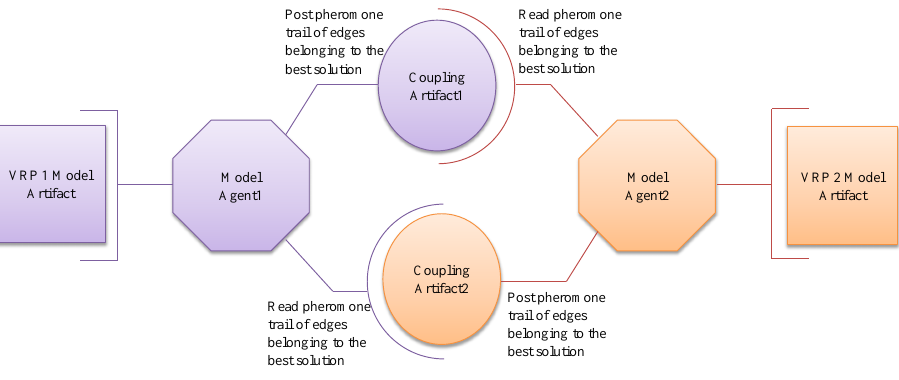
Figure 3. Coupling VRP